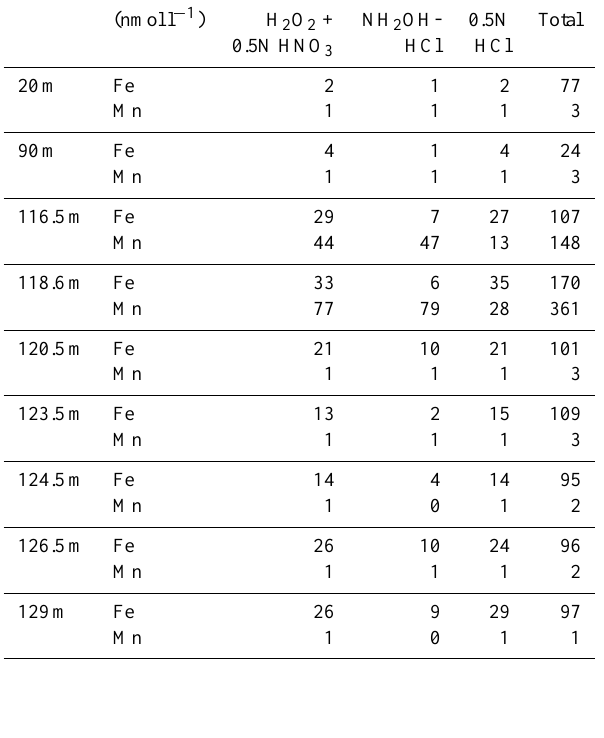
Table 2. Selective and total extractions of Fe and Mn in water col- umn particles.